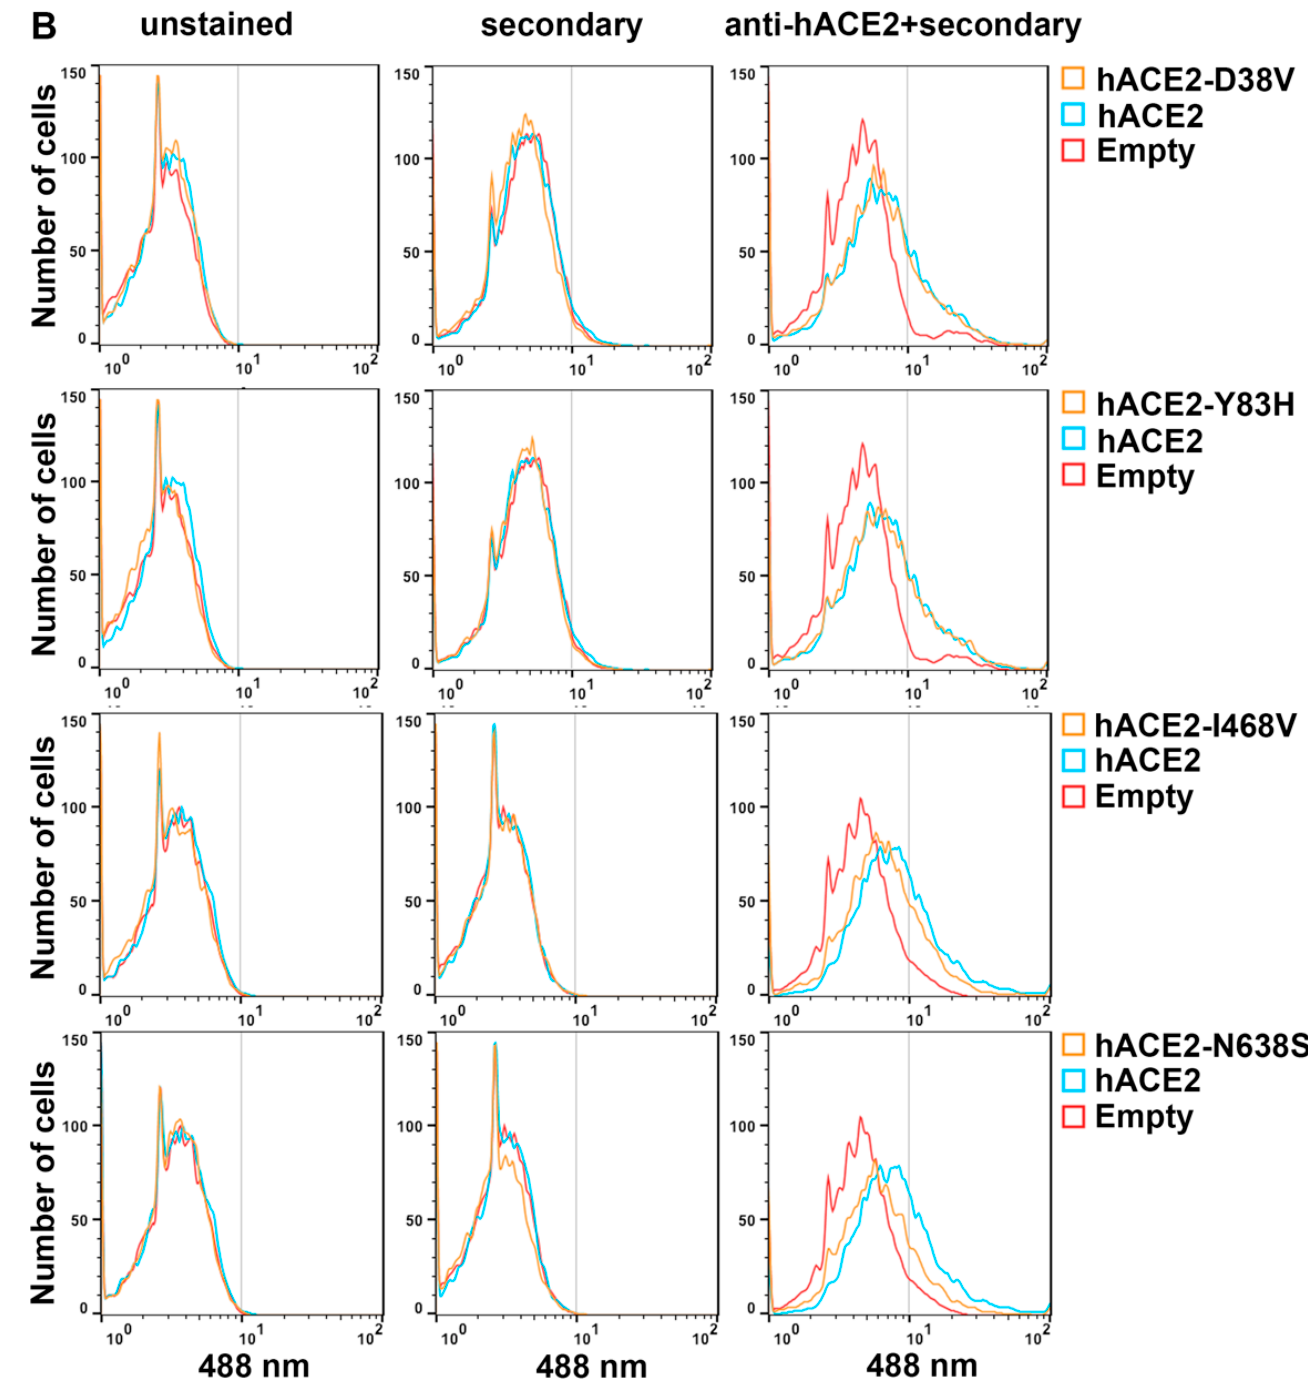
Figure 3. Surface expression in stable cells expressing hACE2 variants. ( A , B ) HEK293 cells stably expressing the different hACE2 variants were analyzed for hACE2 surface expression using flow cytometry using anti-hACE antibodies (unpermeabilized cells). Controls were mock stained or received only secondary antibodies. A total of 10,000 events were recorded. The red population indicates cells transduced with the Pscalps-Puro empty vector. Experiments were repeated at least three times, and representative histograms are shown.